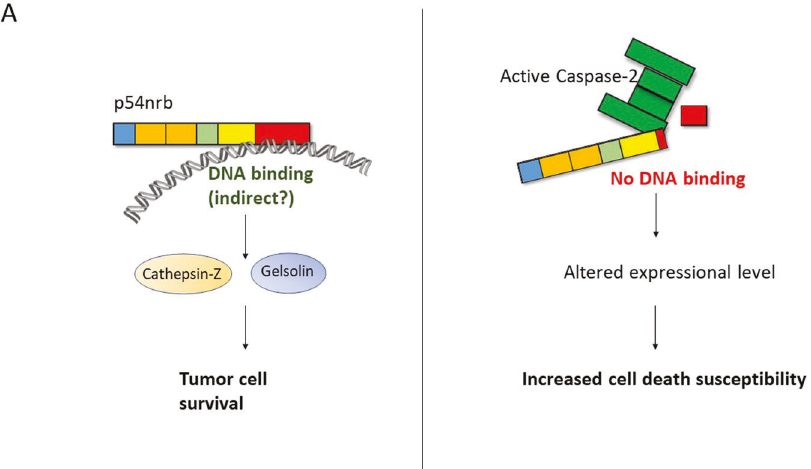
Fig. 6 Cleavage by caspase-2 disrupts the gene regulatory function of p54nrb. A Schematic illustration of p54nrb ’ s gene regulatory function in the presence or absence of active caspase-2 and its subsequent effect on tumor cell